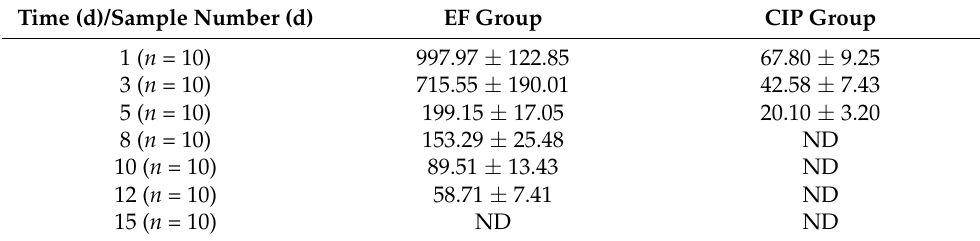
Table 8. Elimination parameters of EF in eggs .